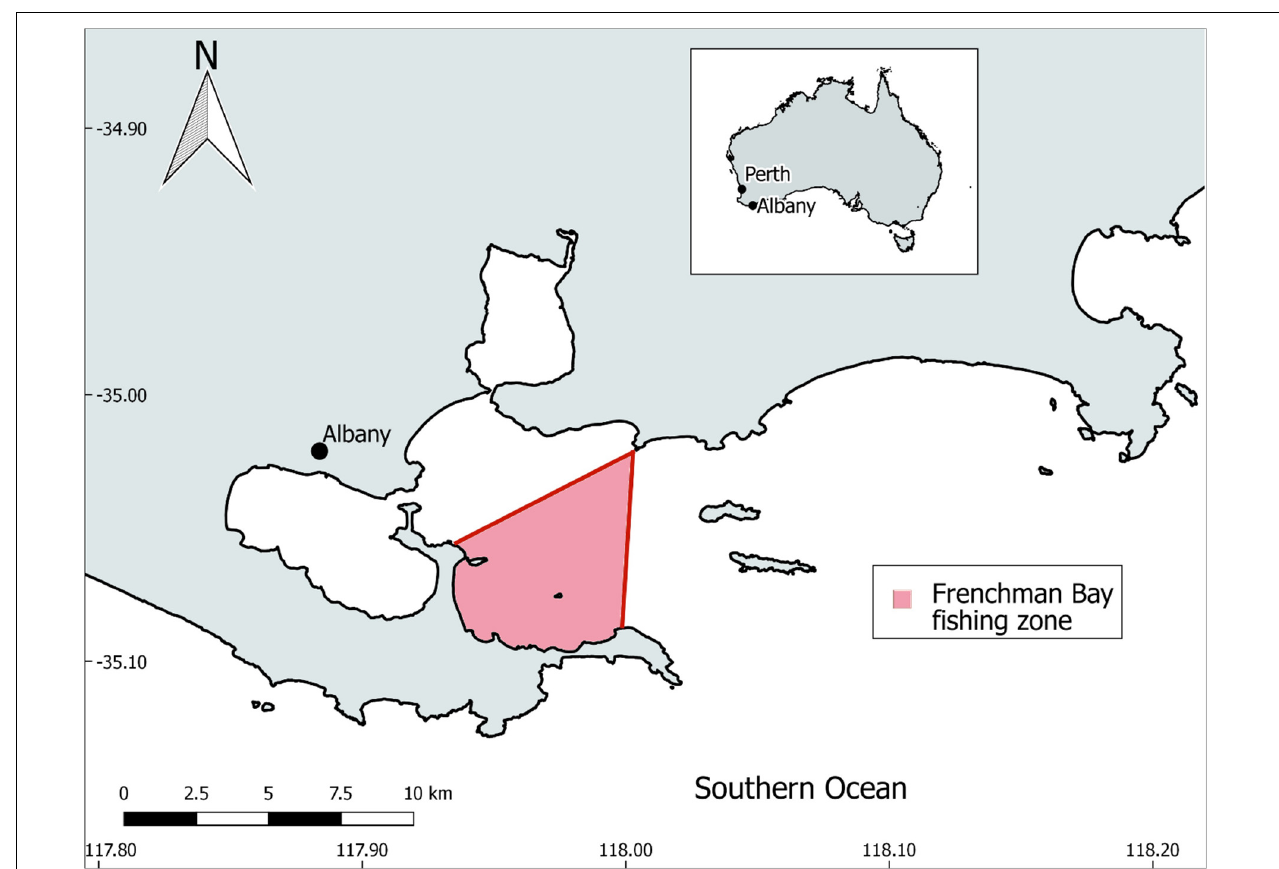
FIGURE 2 | The Frenchman Bay fishing zone, Western